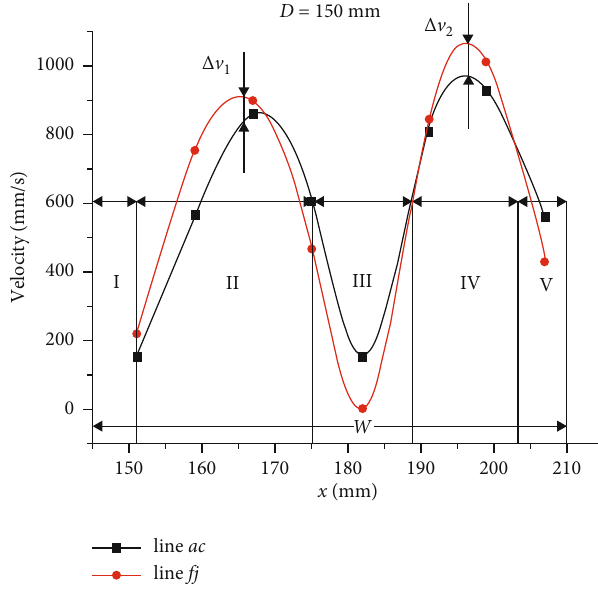
Figure 8: Velocity distribution of fl uid layer at the position y = H /2 near the pin. (I: Region near the fl ight pushing side. II: Region of the left pin. III: Pin and region around the pin. IV: Region of the right pin. V: Region near the fl ight dragging